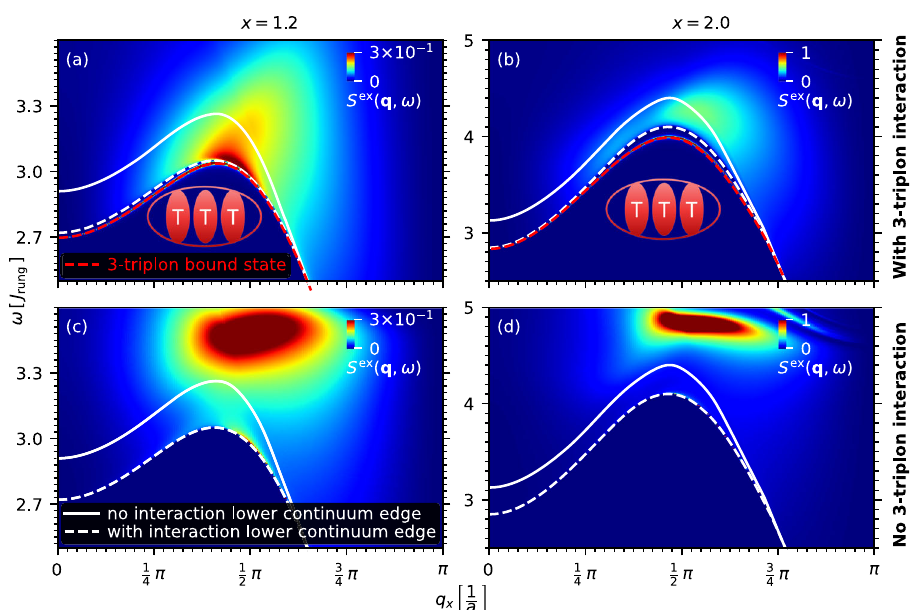
Fig. 4 RIXS response in the S = 0 channel for q y = π / a . Three red ellipses with the letter ‘ T ’ denote bound three-triplon bound states. a , b Result from the mixed deepCUT calculations, (2: n ) generator in order 10 for the single- and two-triplon matrix elements, (3: n )-generator in order ≥ 5 for the three-triplon matrix elements (see Supplementary Methods). The effective observable was computed with the (3: n )-generator. c , d Results from the (2: n ) deepCUT calculations in order 10 excluding irreducible three-triplon interactions. a , c Depict data for x = 1.2 while b and d for x = 2.0.